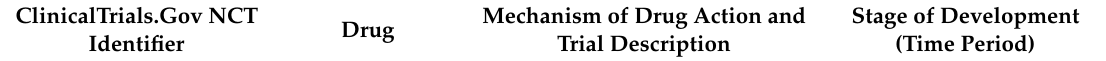
ClinicalTrials.Gov